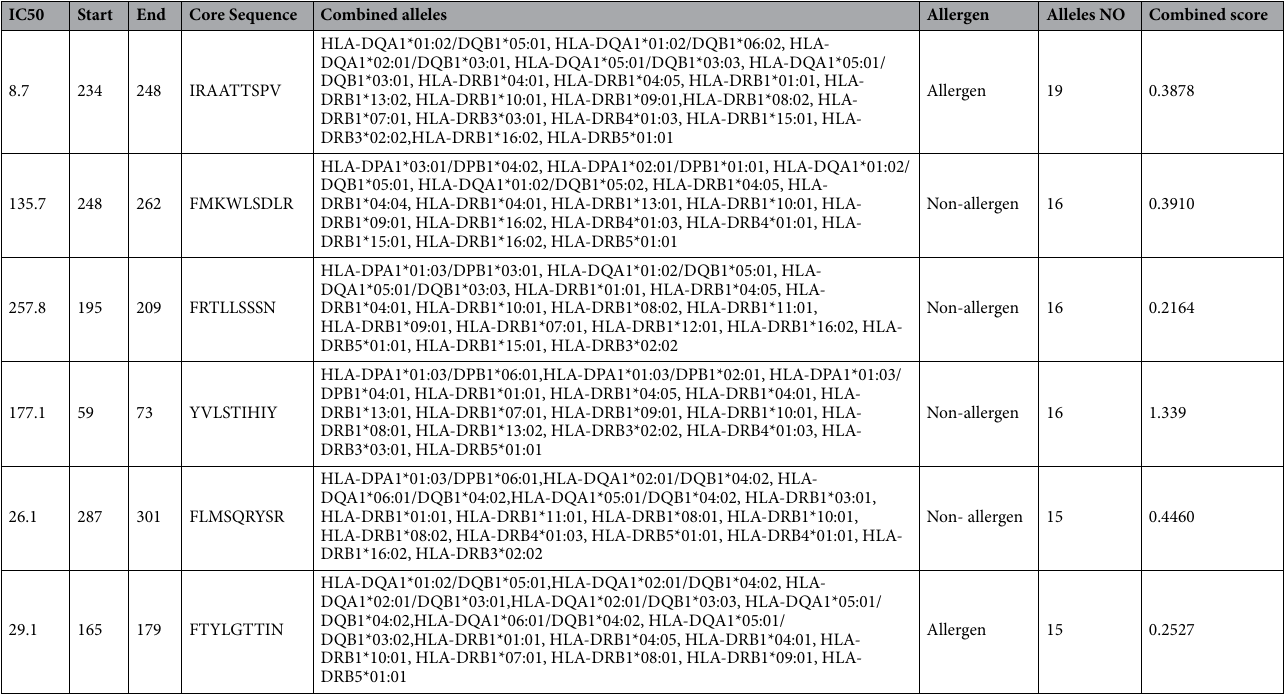
Table 4. MHC II associated peptides and